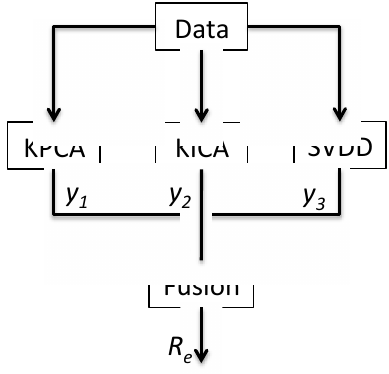
Figure 2. Flowchart of the fault detection.